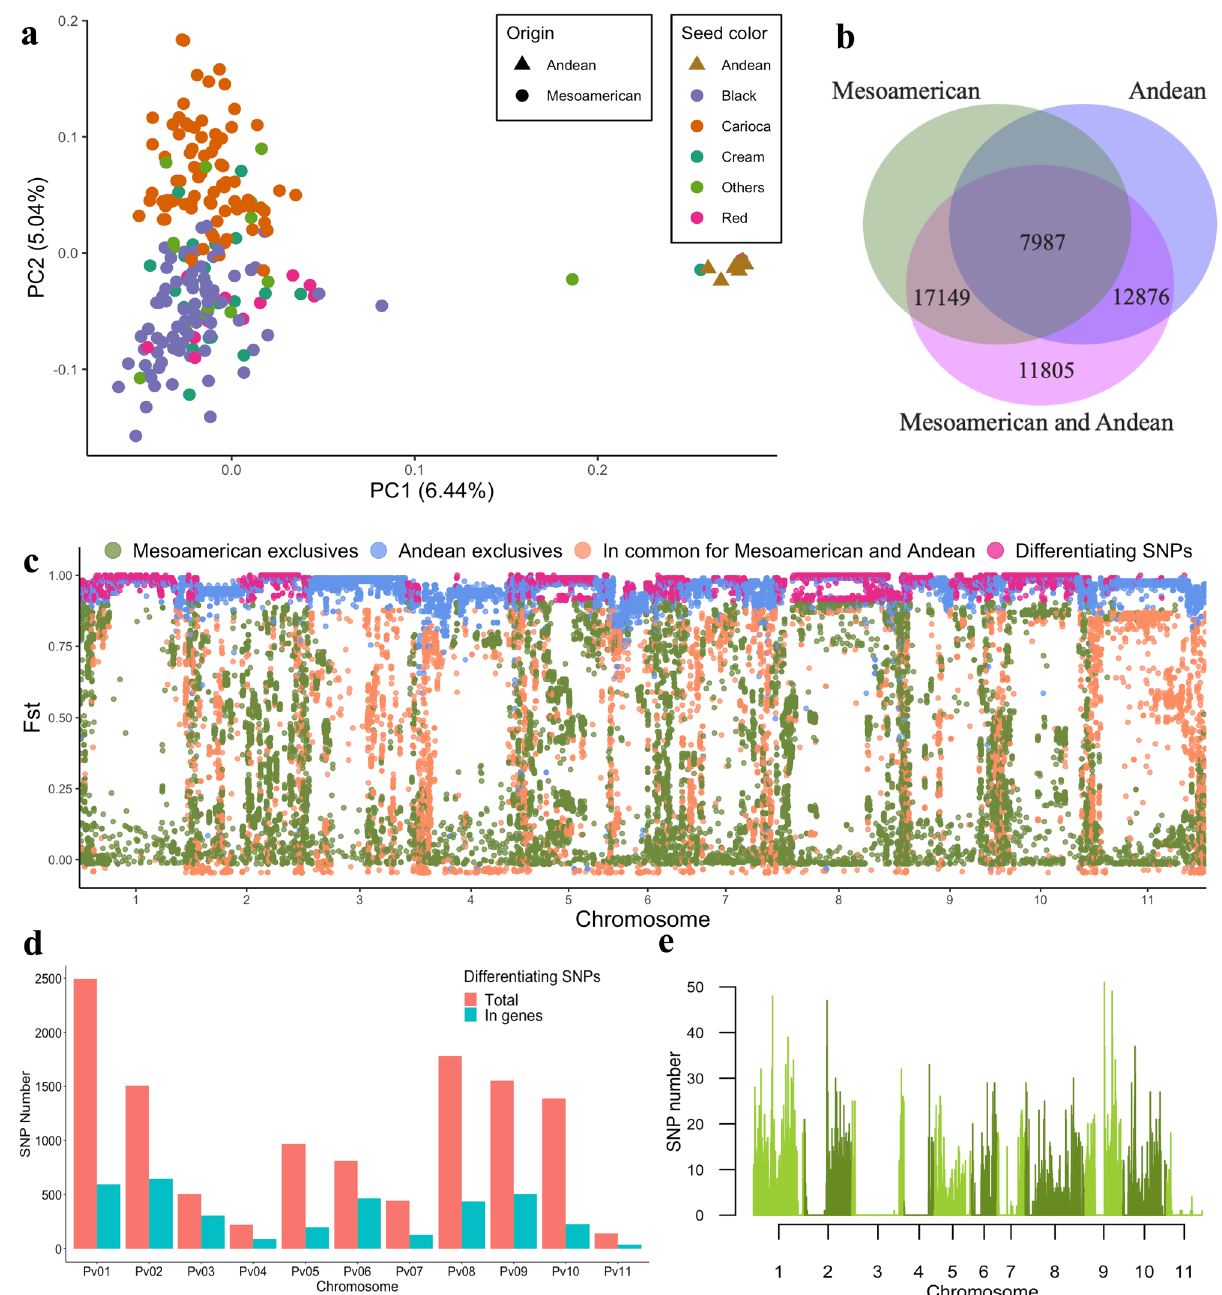
Figure 2. Genetic differentiation between Andean and Mesoamerican gene pools. ( a ) Principal component analysis of 219 accessions of Andean and Mesoamerican origin including different commercial groups (black, carioca, cream, red, etc.). ( b ) Venn diagram of the total set of SNPs and SNPs belonging to the Andean and Mesoamerican groups. ( c ) Distribution of the Fst values of each SNP (colored according to the population in which they occur). ( d ) Total number of differentiating SNPs on each chromosome and number of differentiating SNPs located within genes. ( e ) Distribution of the 11,805 differentiating SNPs of the Andean and Mesoamerican groups along the common bean genome in a 200 kb sliding window. Figures ( a ), ( c ), ( d ) and ( e ) produced in R v.4.0 and Figure b produced in JVENN (http://jvenn .toulo the SNPs were included. The Mesoamerican group showed greater mean nucleotide diversity (π = 0.31) than the Andean group (π = 0.22). Regarding Tajima’s D, the Mesoamerican gene pool showed a positive value (D = 1.50), while the Andean gene pool showed a negative value (D = − 0.50) (Table 2). Most SNPs that differentiate the Andean and Mesoamerican pools were located on chromosomes Pv01